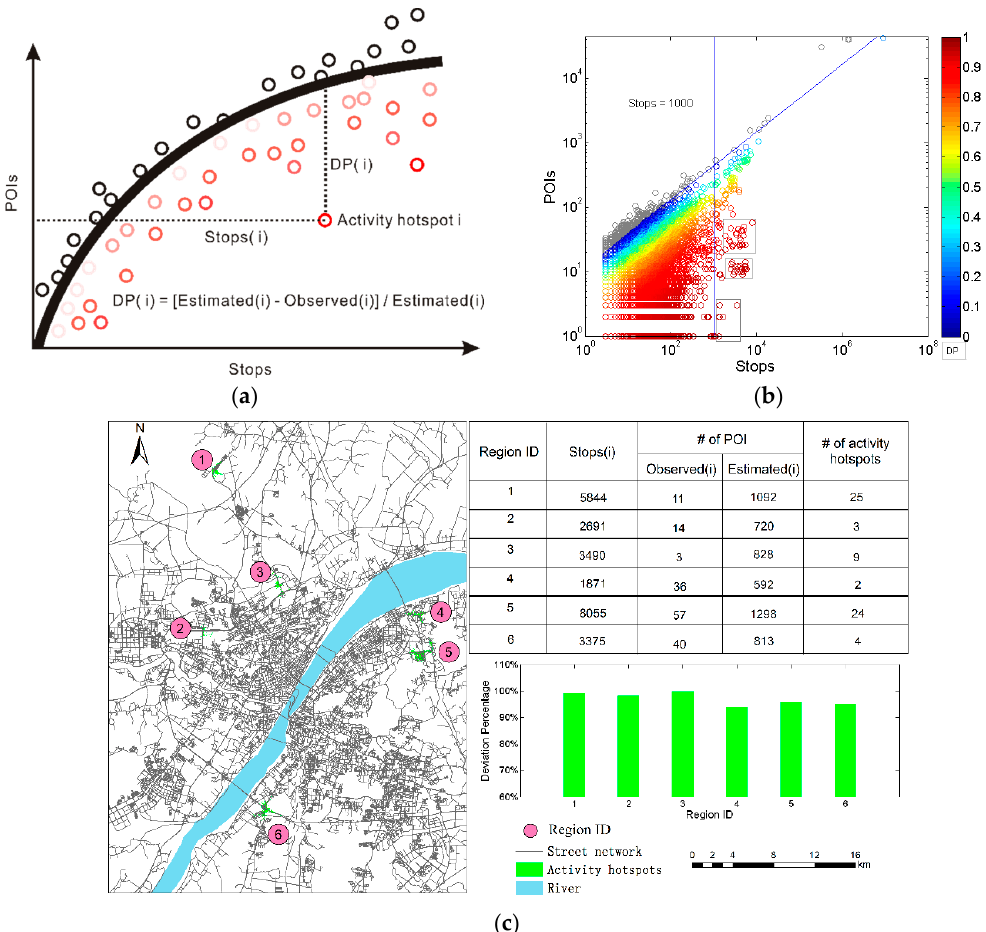
Figure 5. Usage of the allometric ruler: ( a ) schematic illustration of the allometric ruler; ( b ) application of the allometric ruler to human activity hotspots with a time resolution of 15 min in January; ( c ) map of six regions corresponding to the identified activity hotspots.